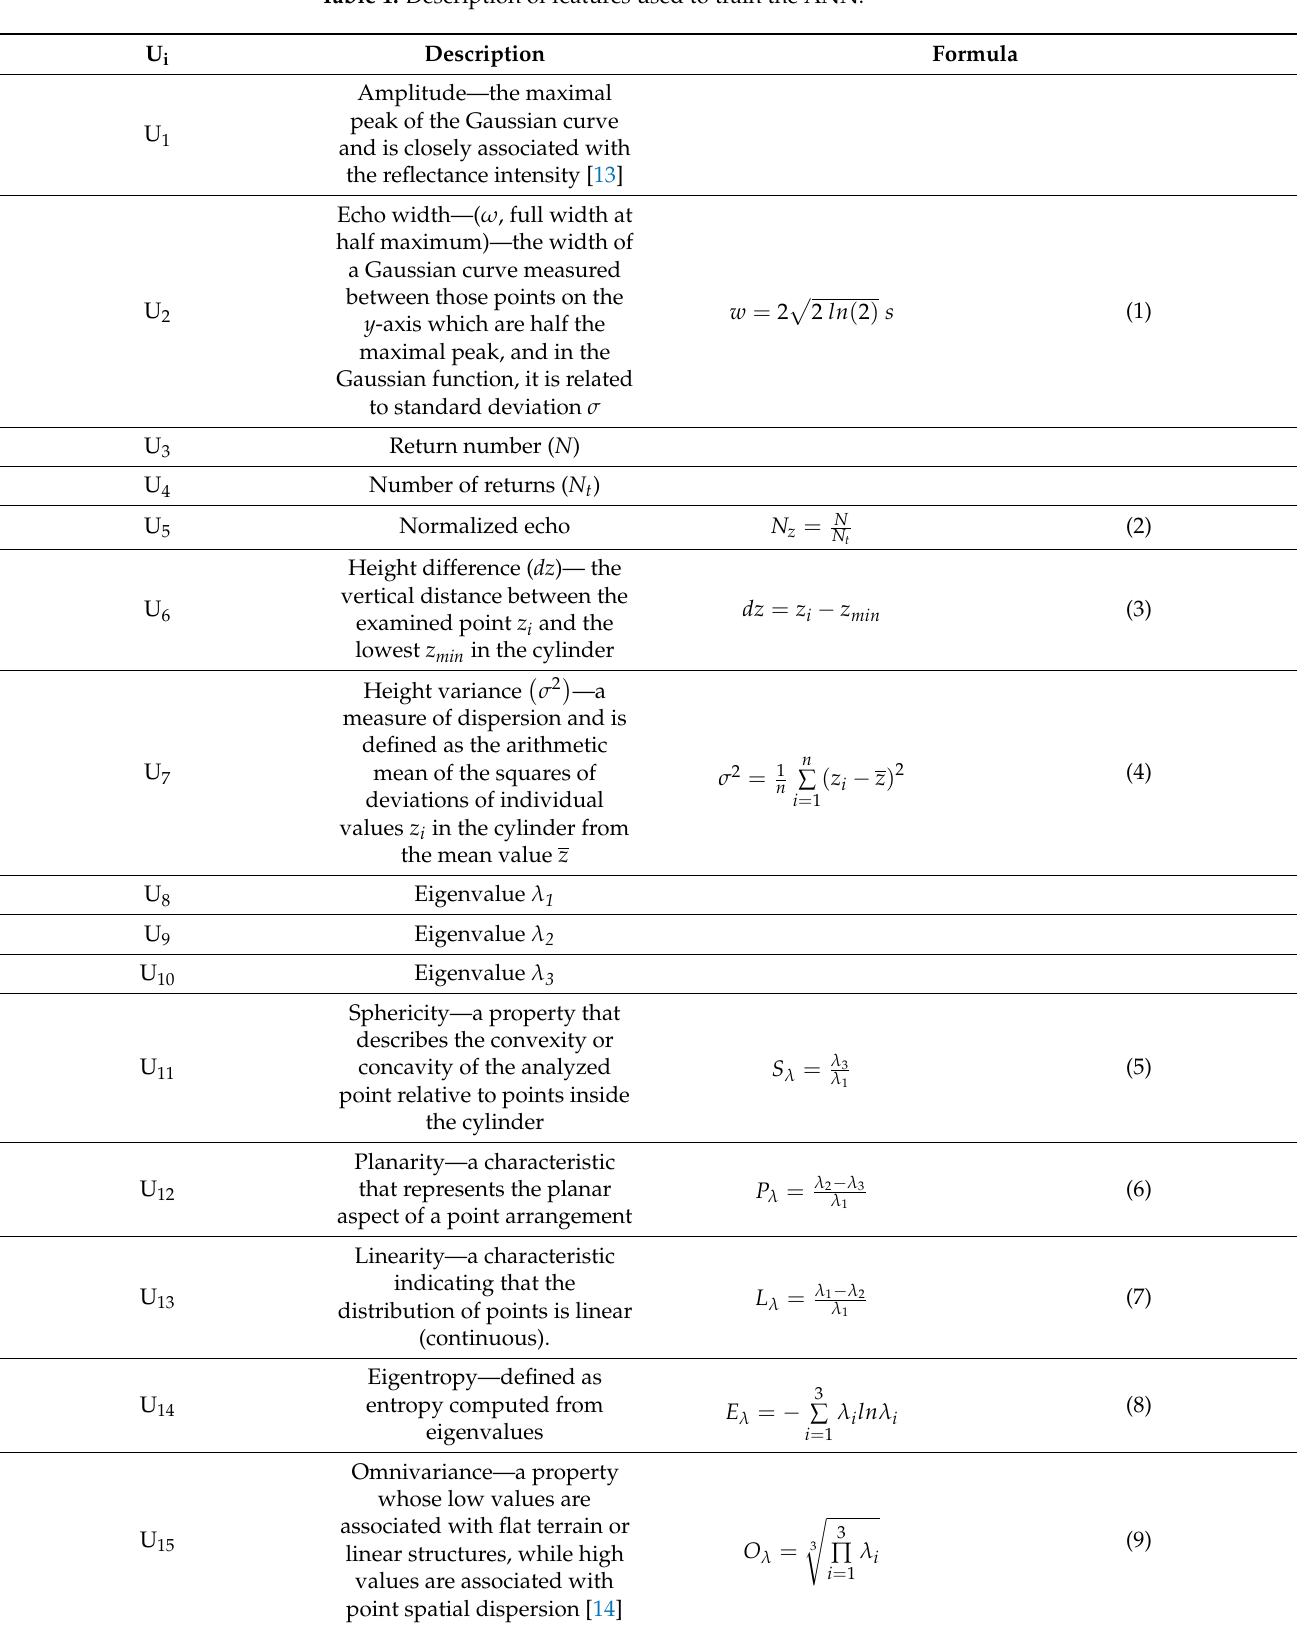
Table 1. Description of features used to train the